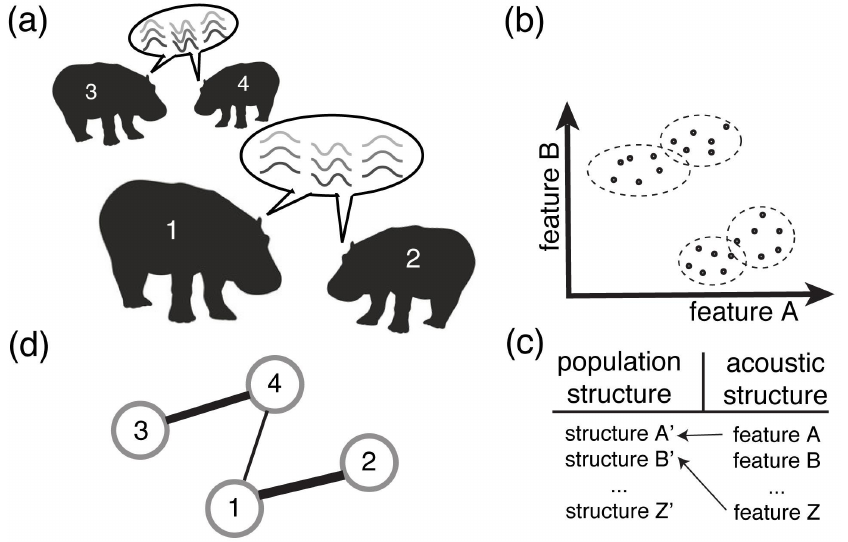
Figure 2. Linking sound structure to population structure. ( a ) Animals are recorded, with or without consideration for non-acoustic socio-environmental variables. ( b ) A range of acoustic features are extracted from each sound sample, and samples are clustered along these features. ( c ) Acoustic structure is mapped to potential features of population structure (e.g., learning from nearby con- specifics, dialects). Numbers refer to different individuals ( d ) Population structure is summarized and visualized, providing a statistical prior for inference about non-acoustic socio-environmental variables (see point